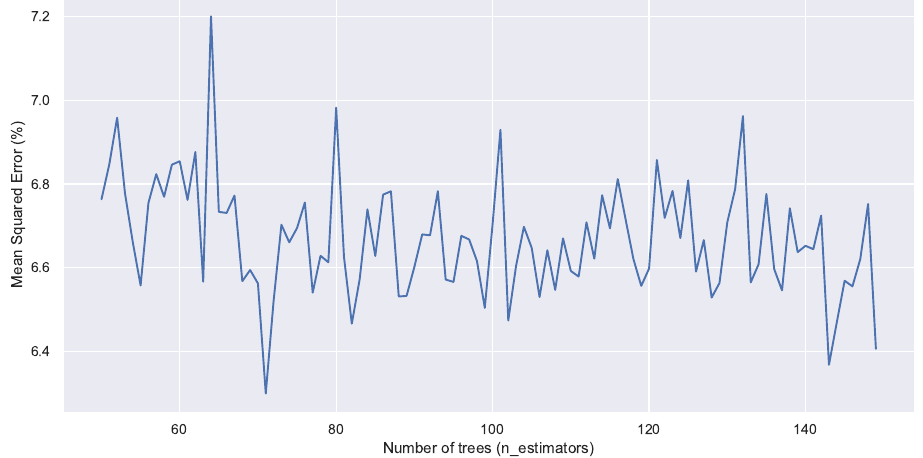
Figure 13. Mean squared error as a function of the number of trees.